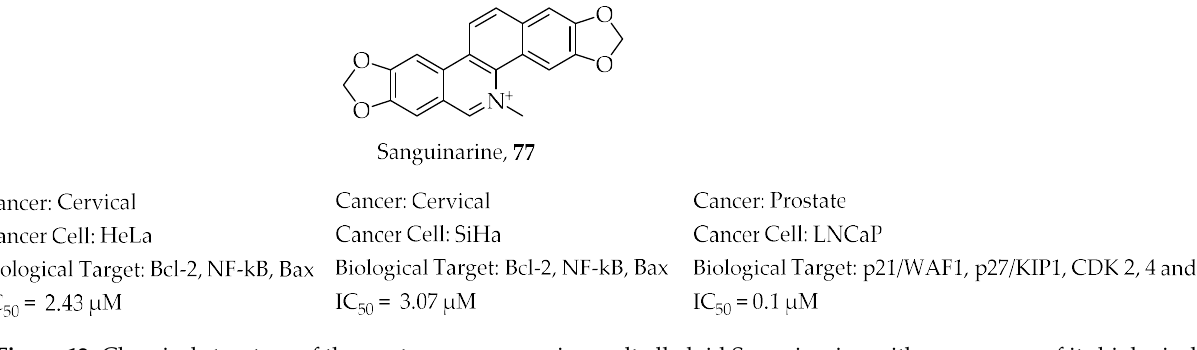
Figure 12. Chemical structure of the quaternary ammonium salt alkaloid Sanguinarine with a summary of its biological activity towards selected cancer targets.